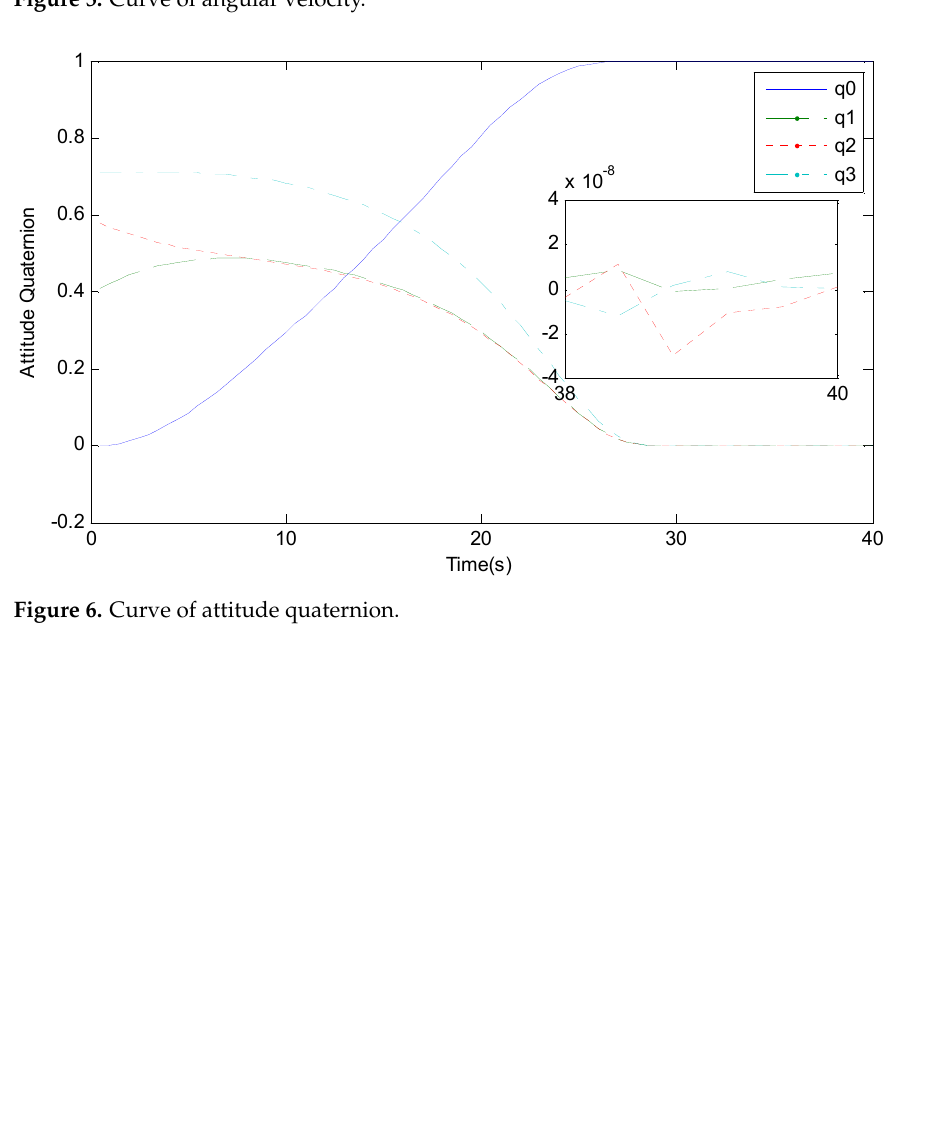
Figure 7. Curve of sliding mode parameter.